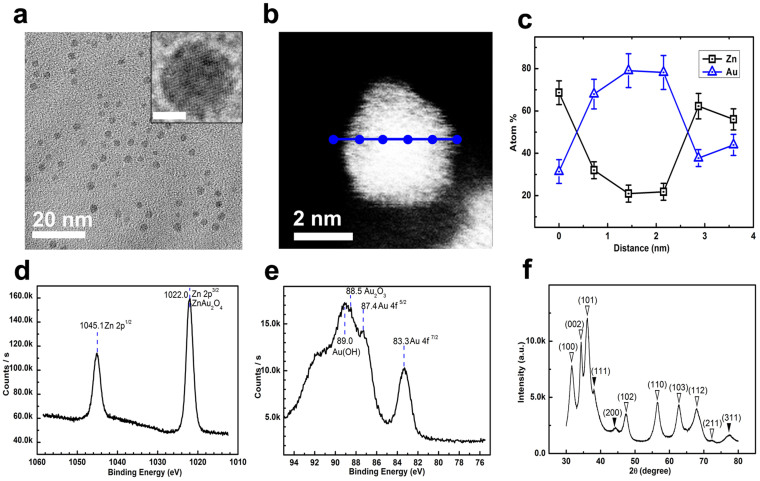
Wide-viewed TEM image (a), HR-TEM image of one single particle (a: inset, scale bar: 2 nm), STEM-HAADF image of one single particle (b), point-by-point EDX scanning of one single particle (c), high energy resolution XPS for Zn (d), high energy resolution XPS for Au (e) and XRD (f) for AuZn@Zn(1-x)AuxOy nanohybrids synthesized using aqueous-phased metal slat reaction systems.JCPDS No for XRD analysis: fcc Au, 05-0727; wurtzite ZnO, 36-1451. In XRD (f), : the corresponding metallic phases; : the corresponding metal oxides.